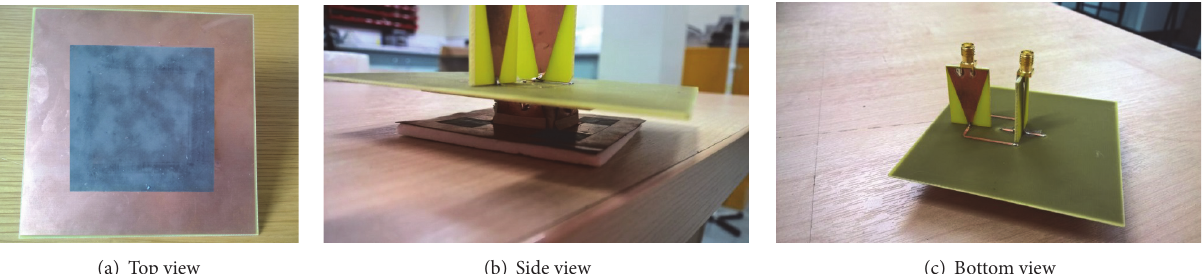
Figure 6: Photo of the fabricated